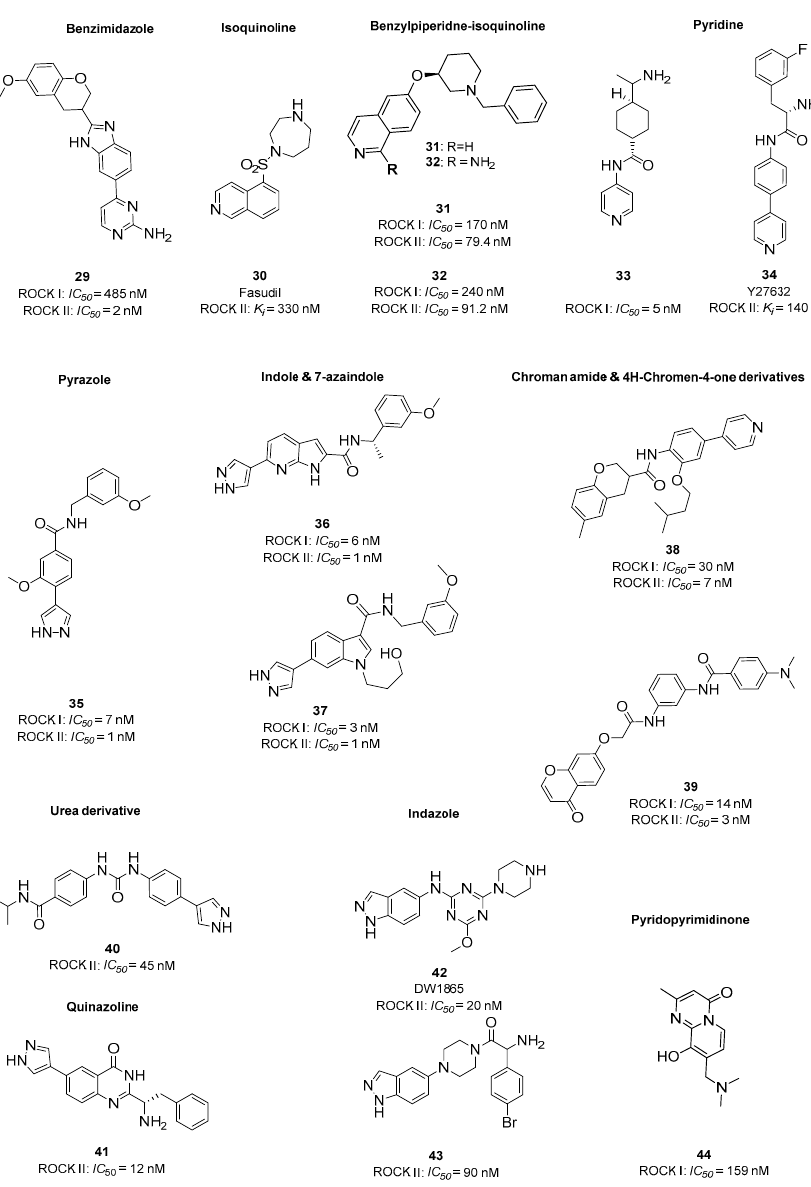
Figure 10. Examples of potent ROCK inhibitors from different chemical classes : 29 [94], 31 [95] , 32 [95] , 33 [96], 34 [97], 35 [98], 36 [99], 37 [100], 40 [102] , 41 [103], 42 [106], 43 [108], 44 [CHEMBL1988581]. ROCK inhibiting potency expressed with either IC 50 or K i values